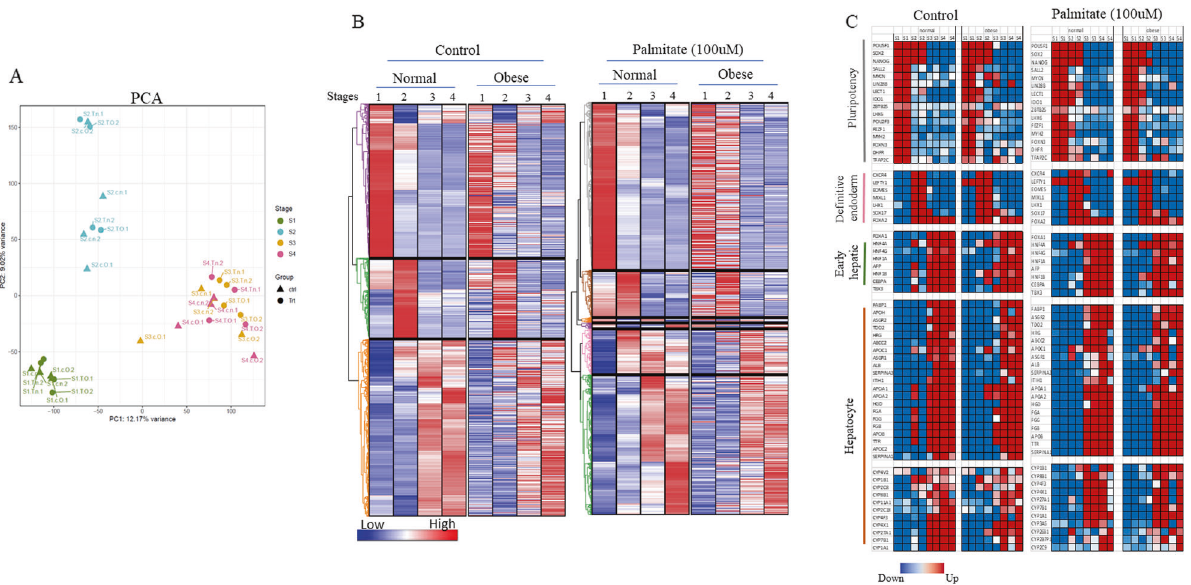
Fig. 2 Whole transcriptome analysis of control and palmitate treated normal and obese iPSCs during in vitro hepatocyte differentiation. A Principal Component Analysis (PCA) on expressed genes from four stages of hepatic differentiation in normal and obese iPSCs in control and palmitate treated conditions. B Hierarchical clustering analysis and corresponding heat map of differentially expressed genes (DEGs) in control and palmitate (100 μ M) treated normal and obese iPSCs from four stages of hepatic differentiation. Hierarchical clustering was performed using Euclidean distance to visualize the expression of genes across groups that were signi fi cant in at least one inter-stage comparison with FDR< 5%. C Heat map of select DEGs from four stages, pluripotency (S1), de fi nitive endoderm (S2), early hepatocyte (S3), and hepatocyte (S4)